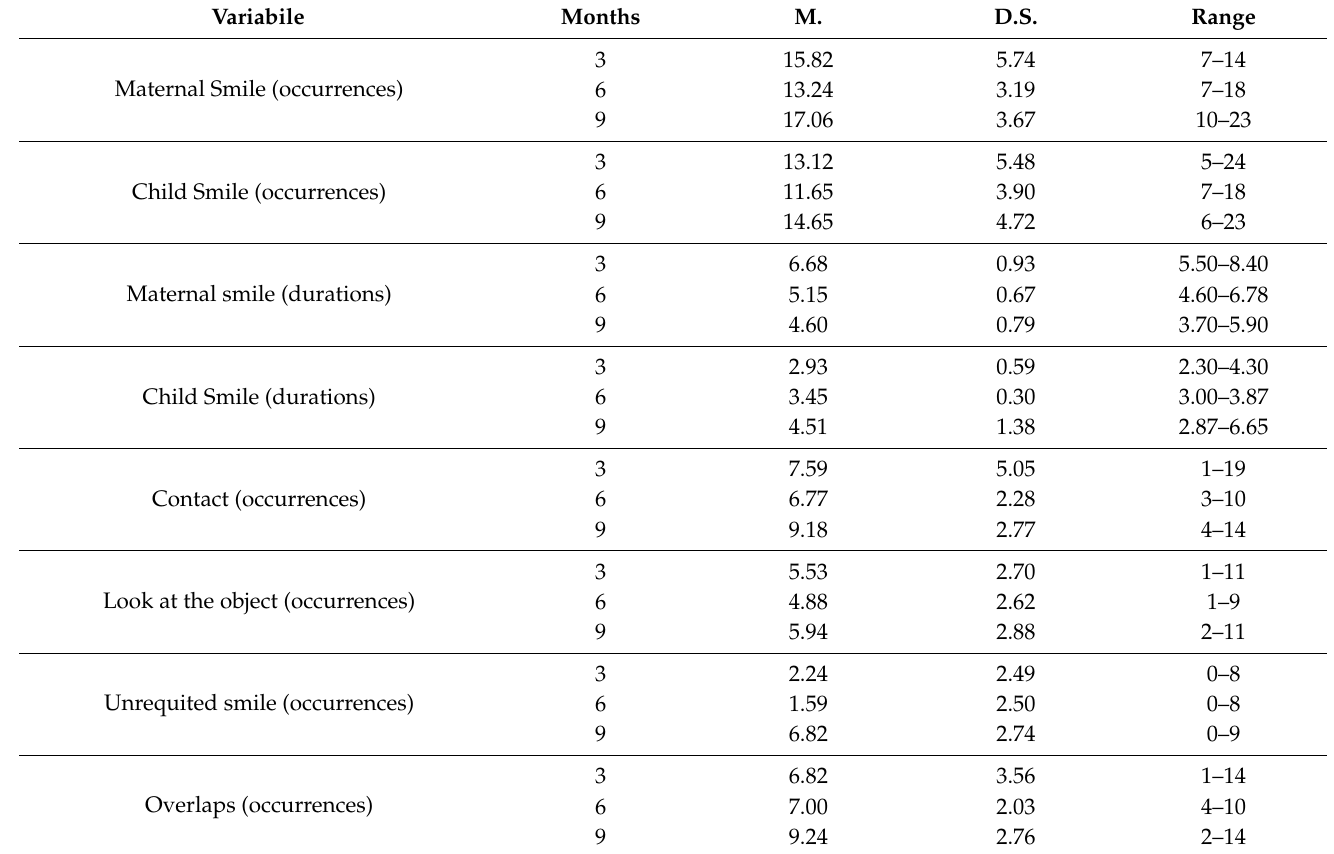
Table 1. Descriptive statistics at three, six, and nine months of the occurrences and duration in seconds of maternal and infant